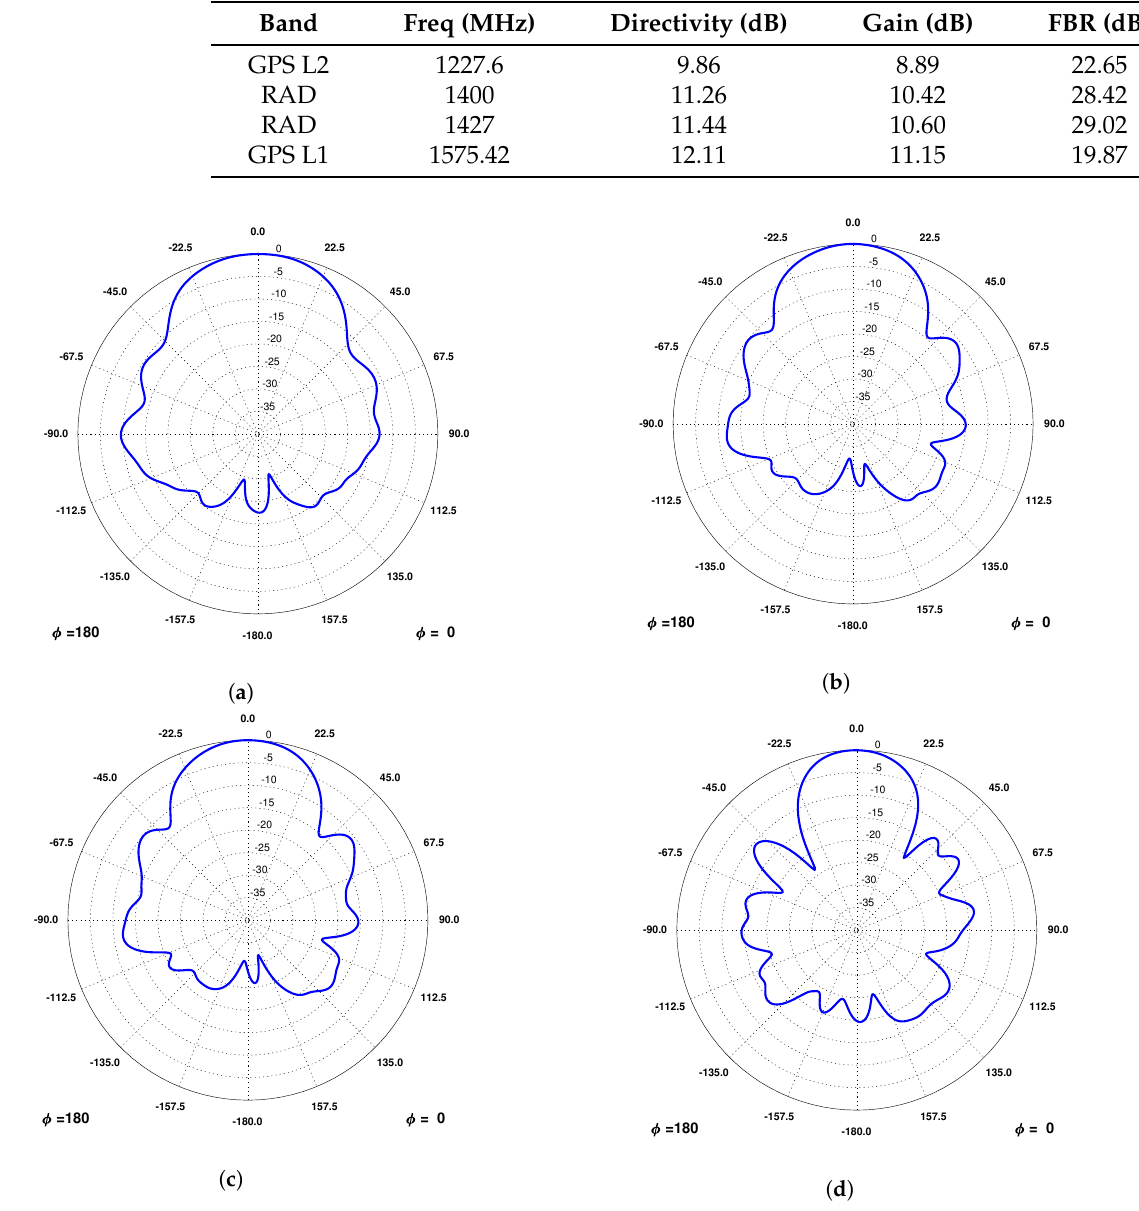
Table 14. Results from the measurements in an Anechoic Chamber of the NADS Flight Model.